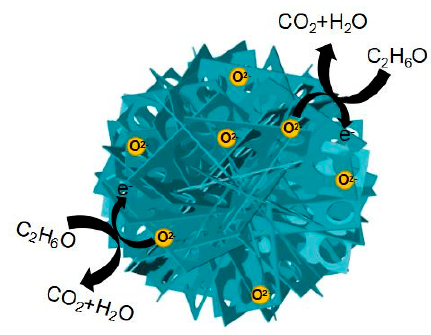
Figure 11. The mechanism of ethanol gas sensing of the In 2 O 3 -8 h micro-flowers.